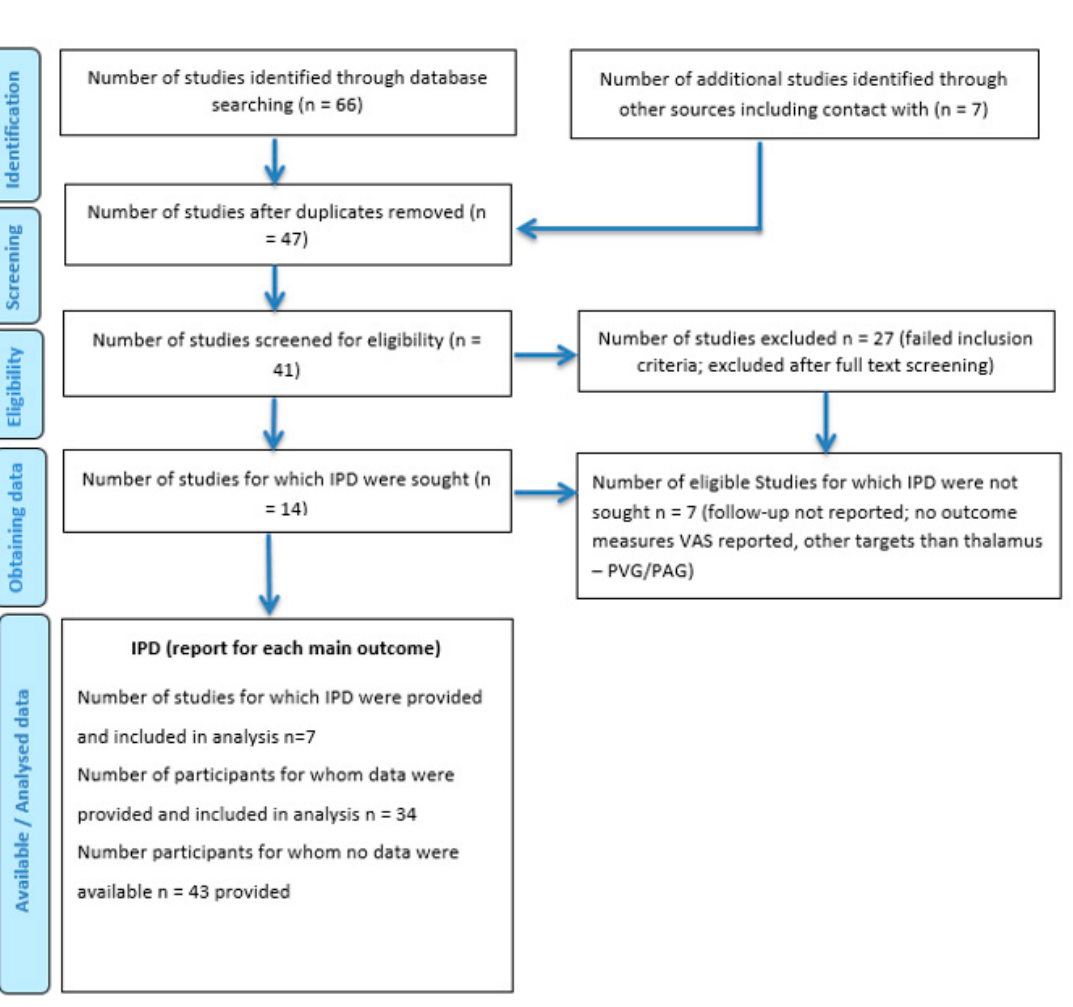
Figure 1. The PRISMA flow-chart of the assessed DBS studies with humans for treatment of facial pain.